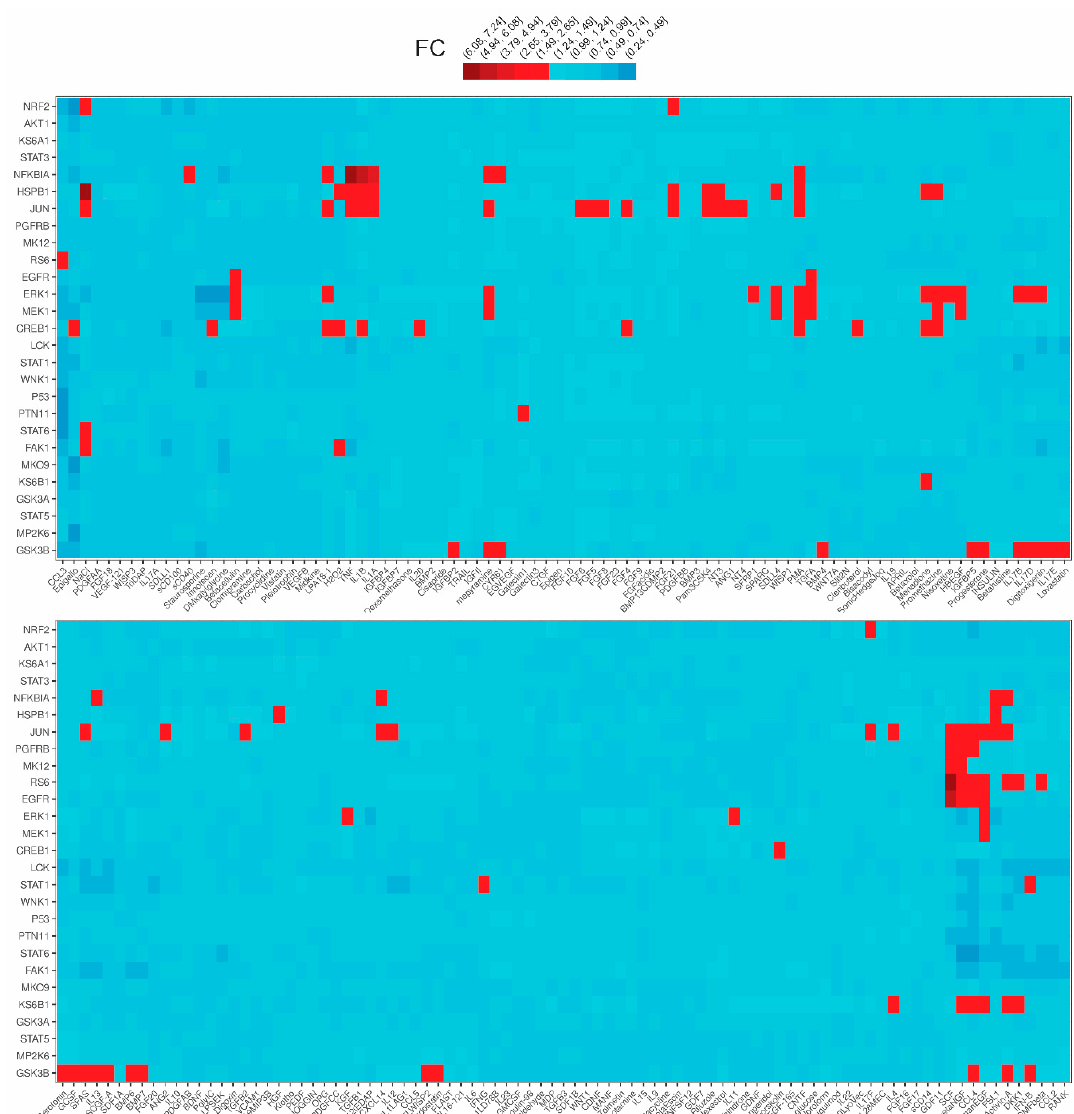
Figure 3. Phosphorylation of 27 major hubs in intracellular signaling pathways of human kidney proximal tubular epithelial cells (HKC-8) upon the stimulation with LPA (18:1) and 175 disparate biological stimuli. The expression was assessed with multiplex ELISA employing microbeads of unique spectral signatures conjugated with monoclonal antibodies specific for each of the 27 phosphoproteins. Red indicates active signals (FC ≥ 1.5). See also Figure S1.